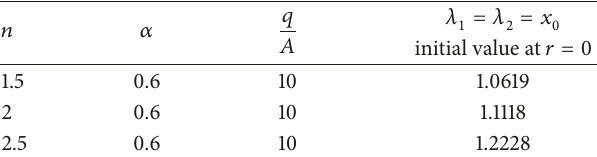
Table 2: The initial value of governing equations with the variation of 𝑛 .